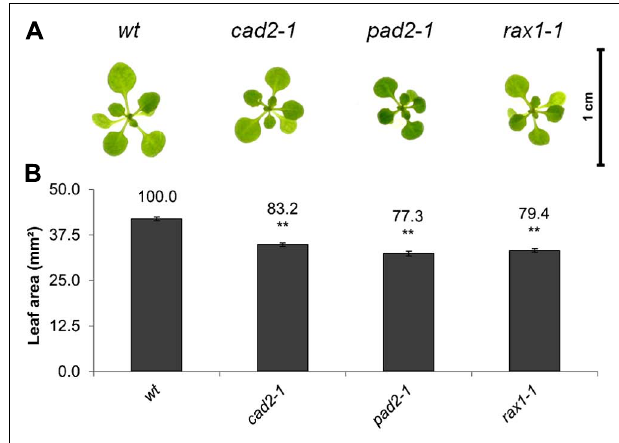
FIGURE 1 |A comparison of rosette leaf area in the rax1-1 , cad2 -1 , and pad2-1 mutants relative to wild type, Col-0 (wt). Phenotypes (A) and leaf area of seedlings at 14 days (B) .The asterisks indicate significant differences ( p < 0.05;